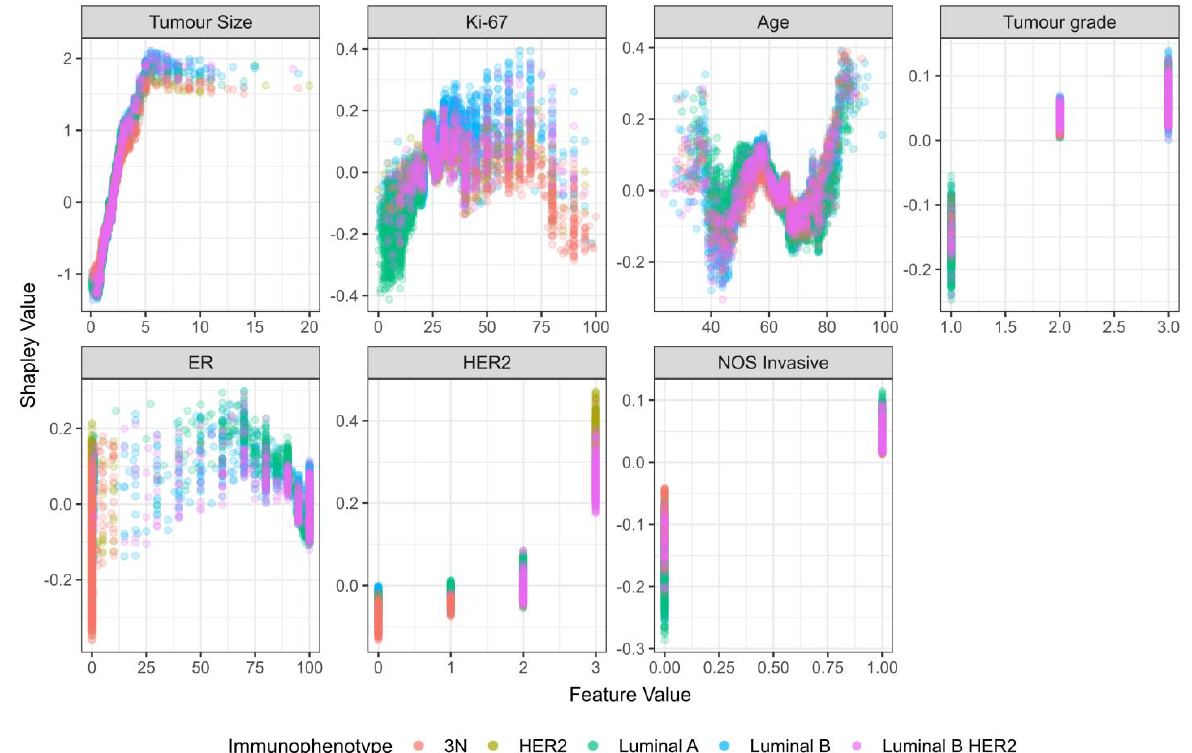
Figure 7. Dependency plot for Shapley values (total study